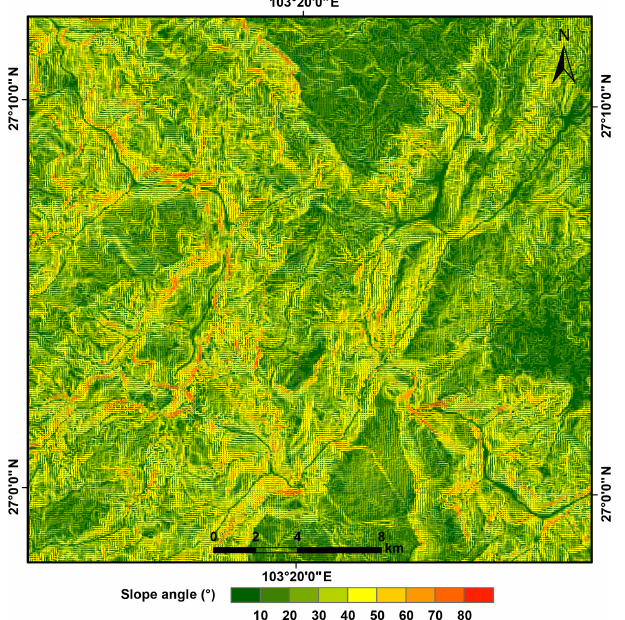
Figure 6. Slope map derived from the DEM of the study area.